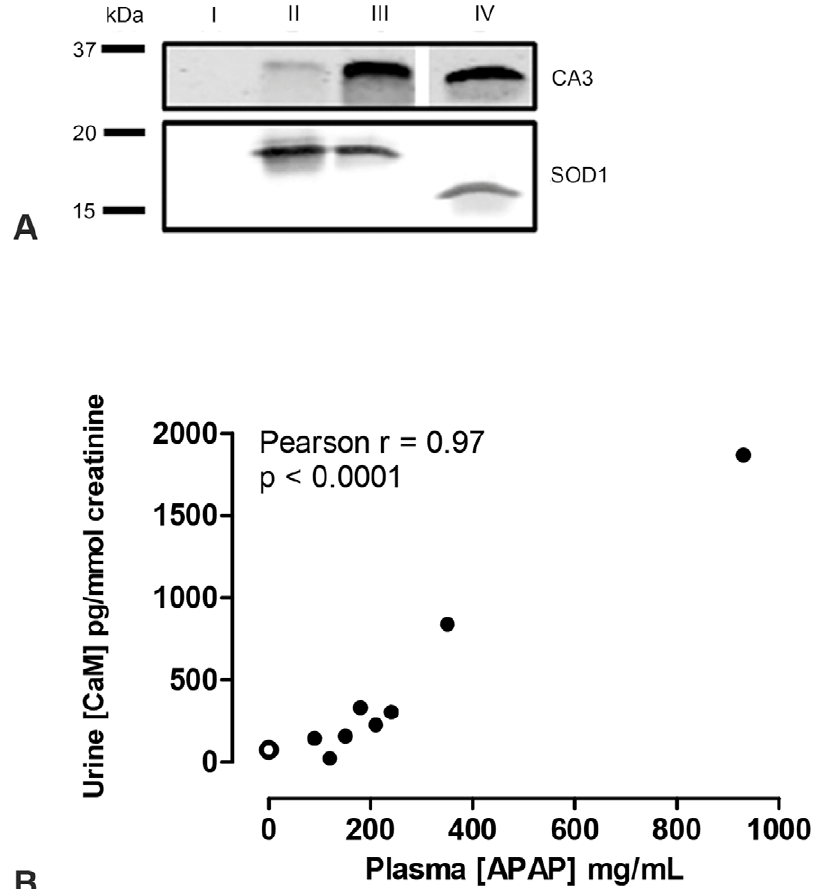
Figure 4. Detection of SOD1, CA3 and CaM in human urine samples. Presence of CA3 and SOD1 was assessed by Western blot in urine samples of masterpool control (I), severe APAP intoxication sample 1 (II) and 2 (III) and a positive control (IV) (panel A). Using an ELISA assay, the urinary concentration of CaM was correlated with plasma APAP concentrations using the Pearson correlation (r) test in patients with an APAP- intoxication, but without elevated plasma ALT values (B). The open data point represents the masterpool control urine sample. ALT: alanine aminotransferase; APAP acetaminophen; CA3: carbonic anhydrase 3; CaM: calmodulin; SOD1: superoxide dismutase 1.